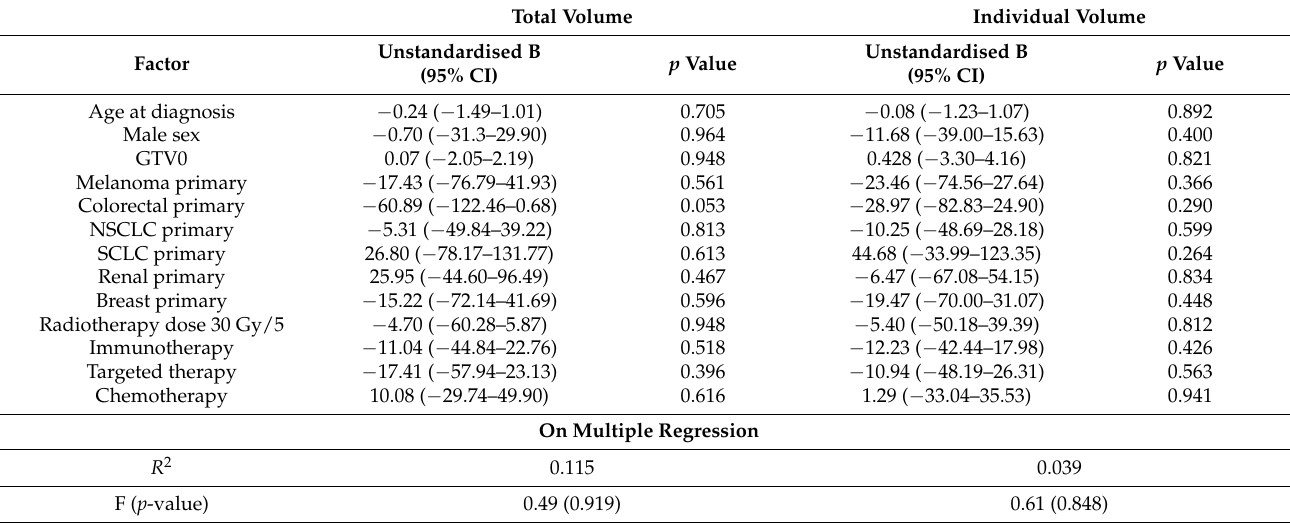
Table A1. Factors predicting change in volume at one month post-HFRT on individual linear regression. HFRT = hypofrac- tionated